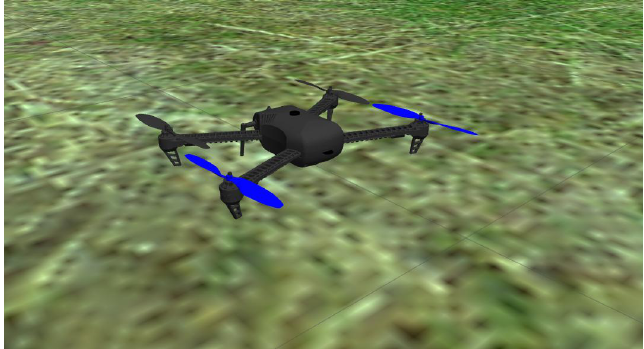
Figure 7. IRIS UAV used in the